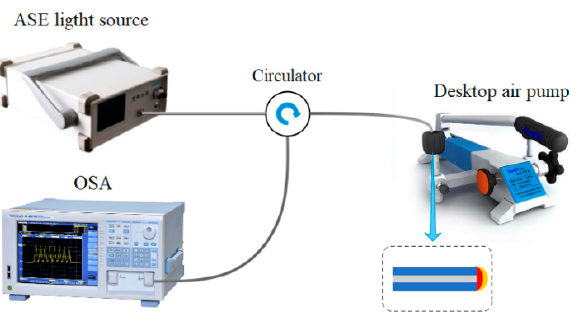
Figure 9. Pressure detection system.